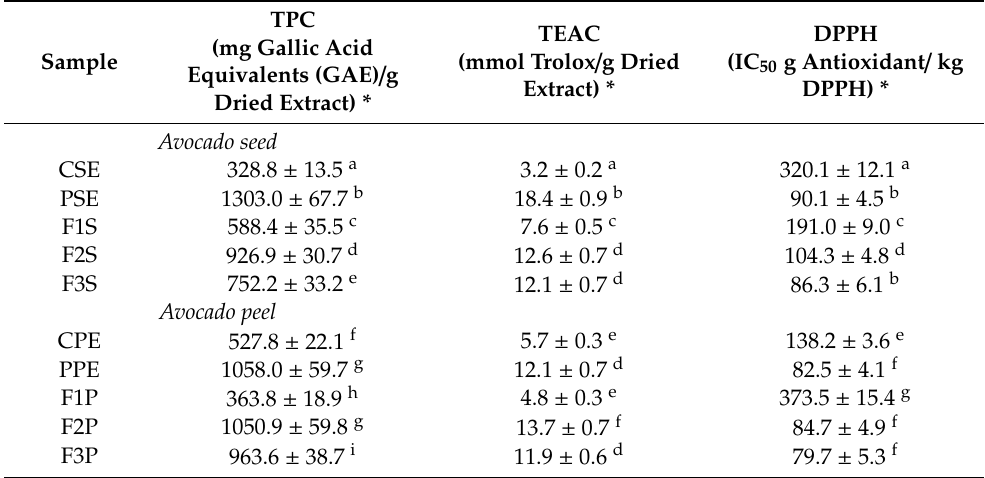
Table 1. Comparison of antioxidant capacity results of seeds and peels avocado ( Persea americana Mill. Nariño cultivar) extracts and